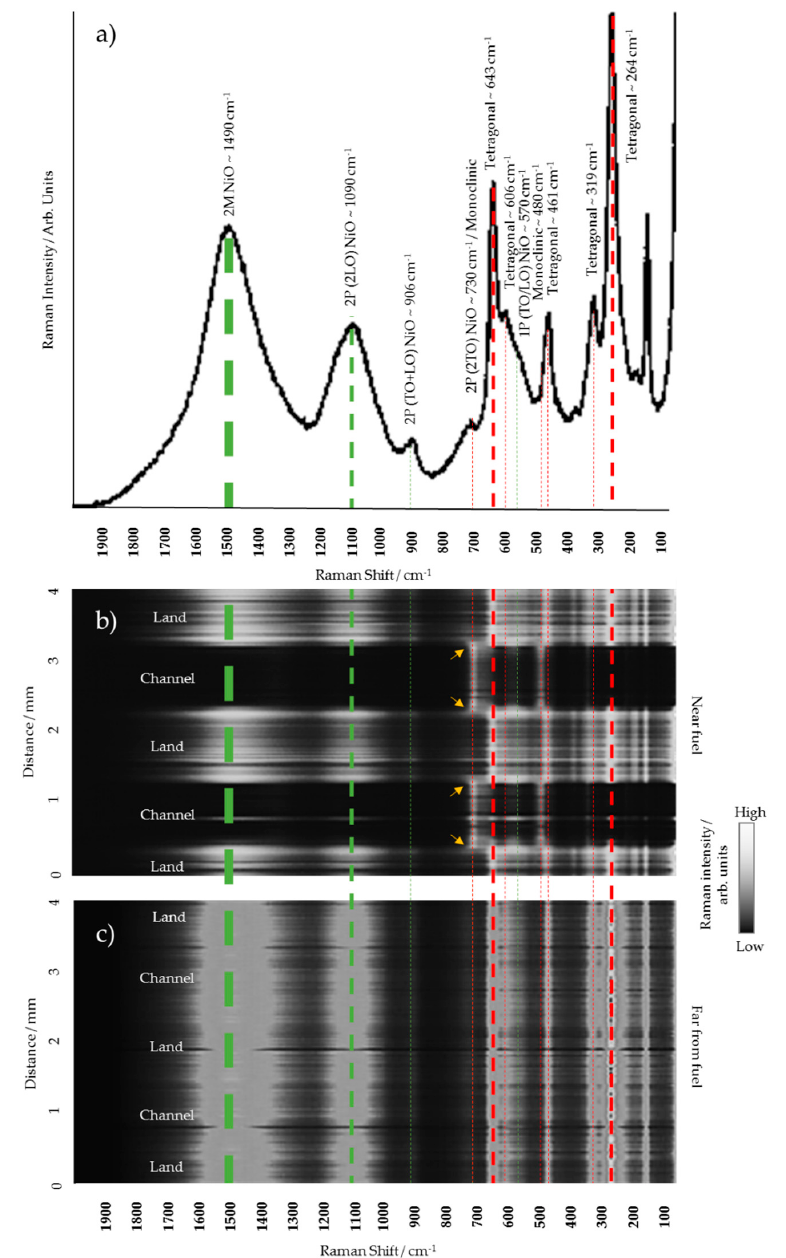
Figure 2. Raman spectroscopy line scans from a partially-reduced SOFC anode: ( a ) Raman intensity profile taken from a green region with particular peaks of interest highlighted (Ni-based in green, YSZ-based in red); line scans whereby black and white respectively refer to high and low Raman intensities for the anode surface ( b ) near and ( c ) far from the fuel